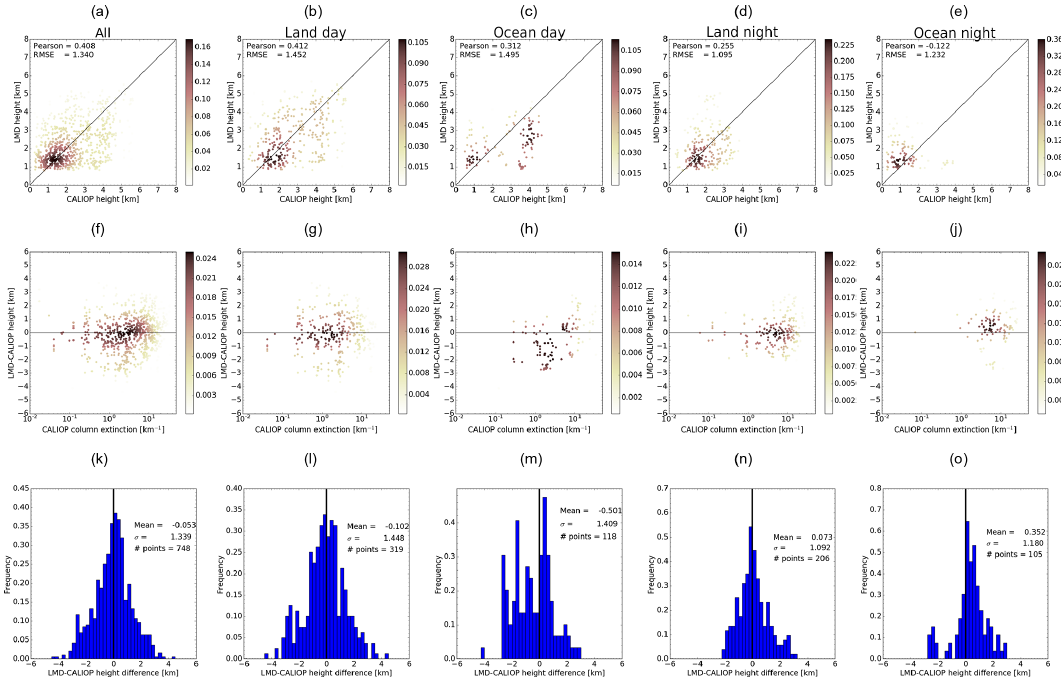
Figure A7. Similar to Fig. A5 but for the LMD algorithm.